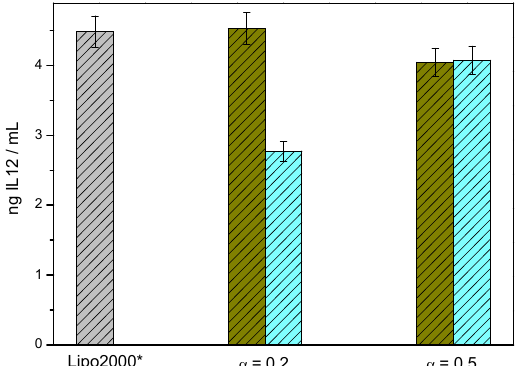
Figure 7. Transfection activity of C 3 (C 16 His) 2 /DOPE-pDNA lipoplexes in COS-7 cells at two molar fractions of the C 3 (C 16 His) 2 cationic lipid in the C 3 (C 16 His) 2 /DOPE mixed lipid ( α = 0.2 and 0.5) carrying plasmid pCMV-IL12. The green and blue bars correspond to effective charge ratios ρ eff = 4 and 10 of the lipoplex, respectively. Gray bar: Lipo2000* as the positive control. The data represent the mean ± SD of three wells and are representative of three independent experiments.